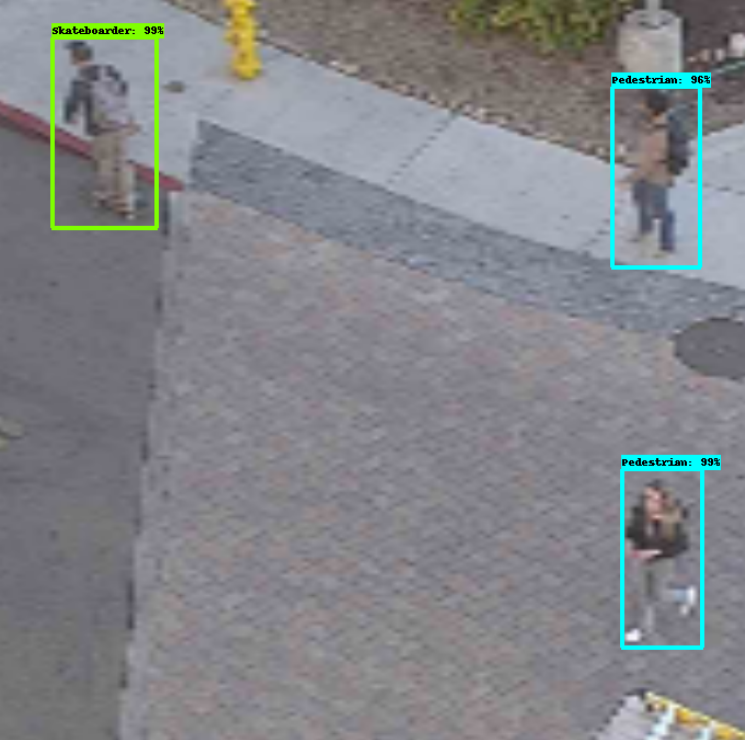
Figure 19. The SSDV2 model evaluates the skateboarder as 99%, one pedestrian as 96%, and the other pedestrian as 99%.The image is pixelated due to its shrinkage from original shape to 300 × 300. This was necessary because this particular model only takes an input dimension of shape 300 ×